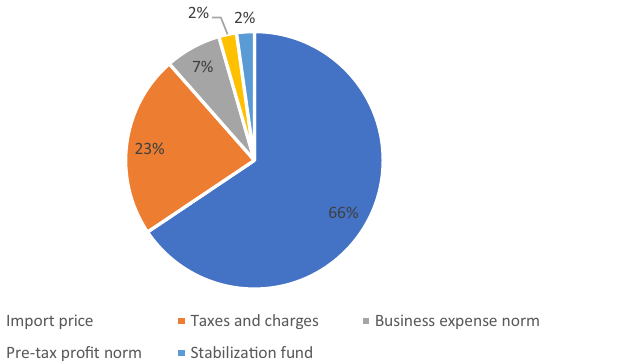
Figure 2. Fuel price composition